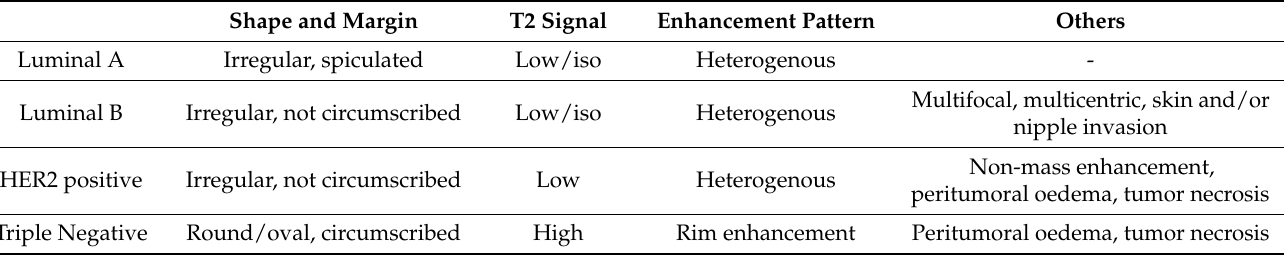
Table 1. MRI main features of breast cancer molecular